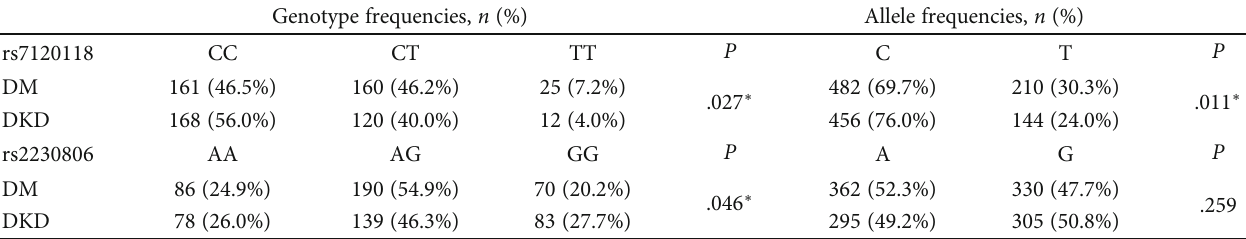
Table 2: Genotype and allele frequency of SNPs rs7120118 and rs2230806 between DM controls ( n = 346 ) and DKD patients ( n = 300 ). Genotype frequencies, n (%) Allele frequencies, n (%)